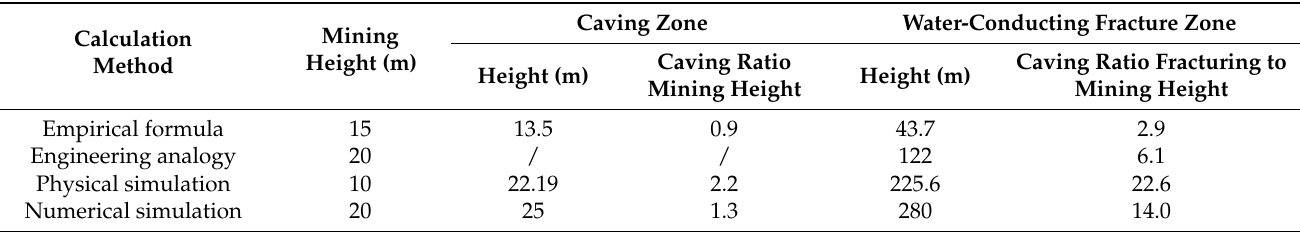
Table 4. Heights of the caving zone and the water-conducting fracture